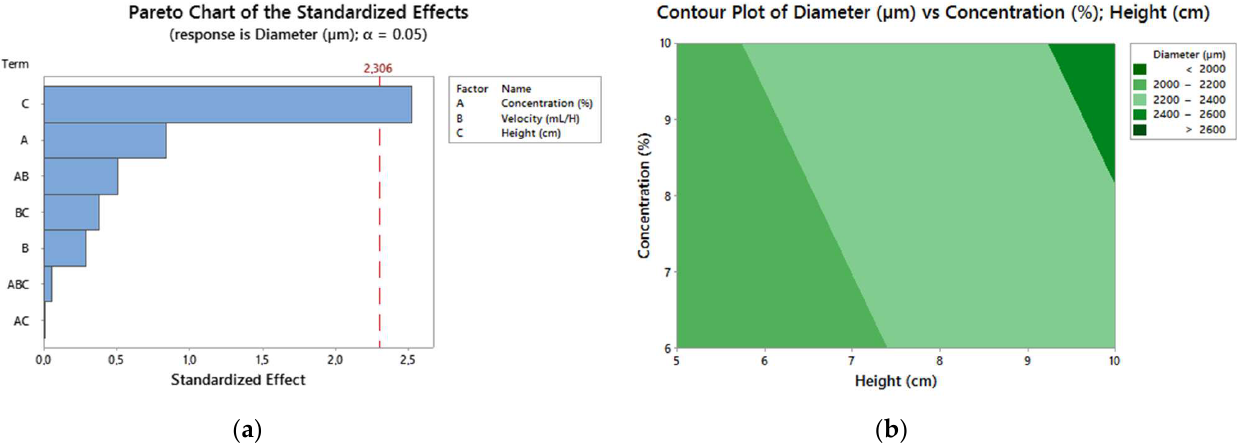
Figure 5. ( a ) Pareto chart; ( b ) contour chart.